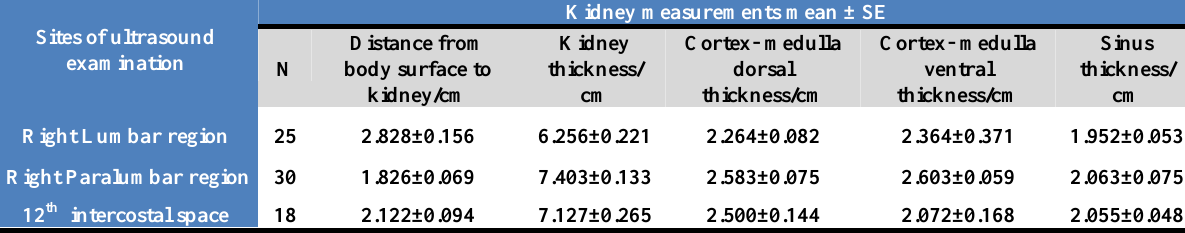
Table, 1: Right kidney ultrasonographic measurements (Mean±SD) in normal adult buffaloes Sites of